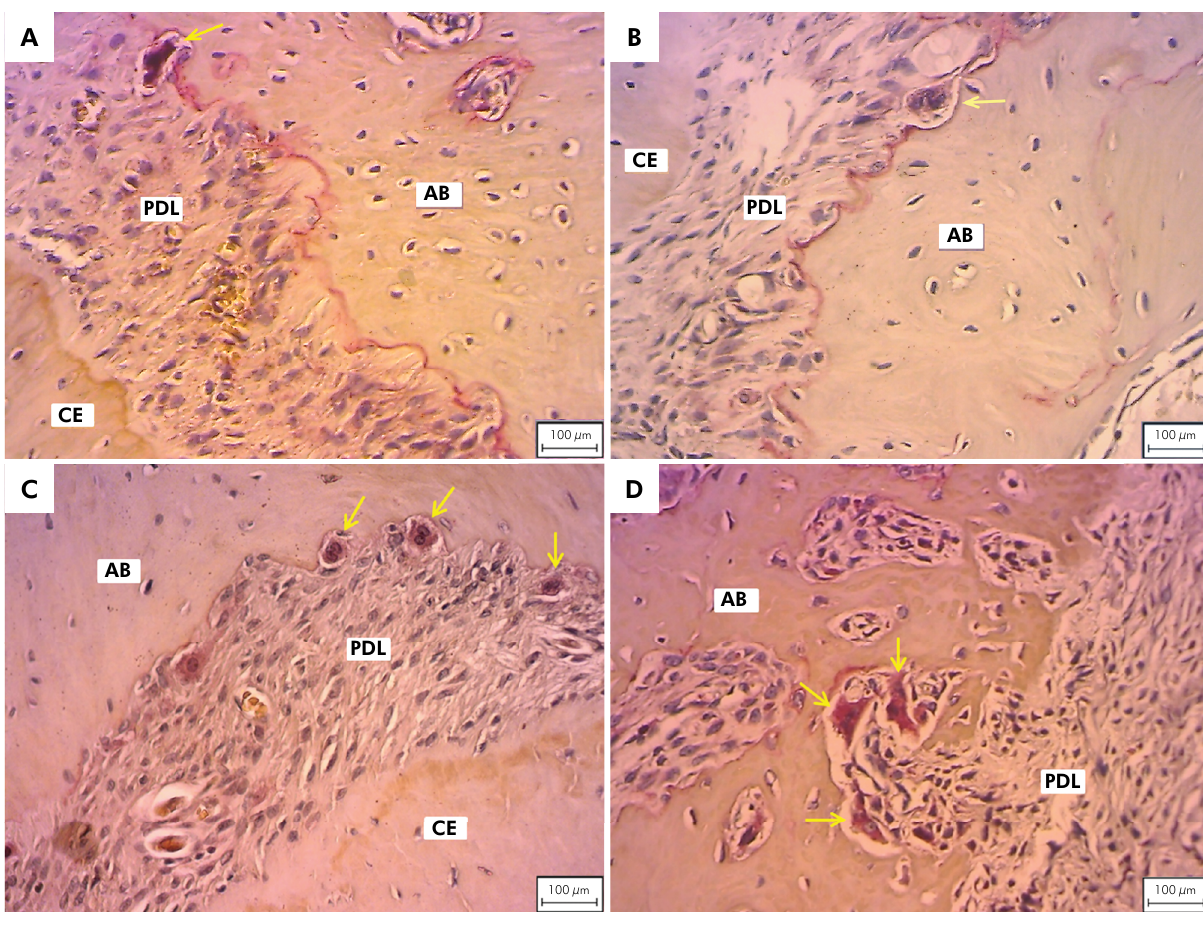
AB: alveolar bone; PDL: periodontal ligament; CE: cement. The yellow arrows indicate osteoclasts. (TRAP, 400x). Figure 3. Photomicrographs of the S (A), F (B), SM (C), and FM (D) groups on the 28 th day of orthodontic tooth movement.